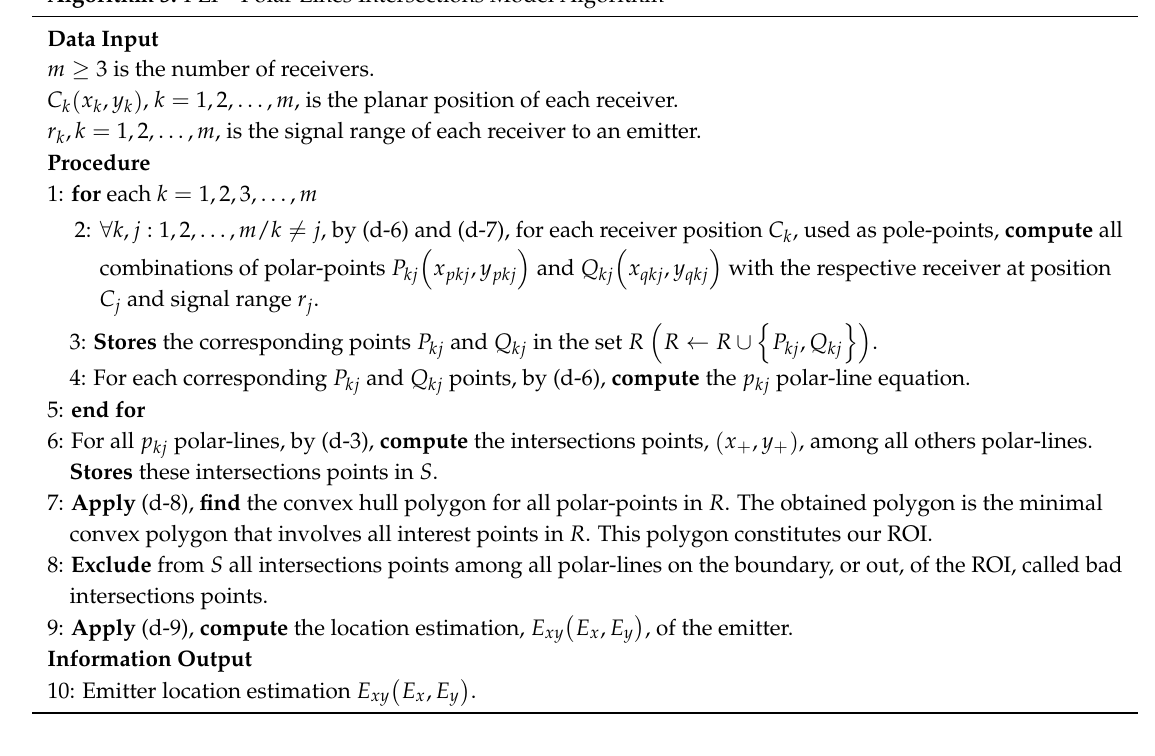
Figure 9. Result produced by PLI four receivers system. The non-symmetrical points are removed from the ROI by the use of Convex Hull. For this case is better applying the exact solution provided by Section 2.1. Algorithm 3. PLI—Polar Lines Intersections Model Algorithm Data